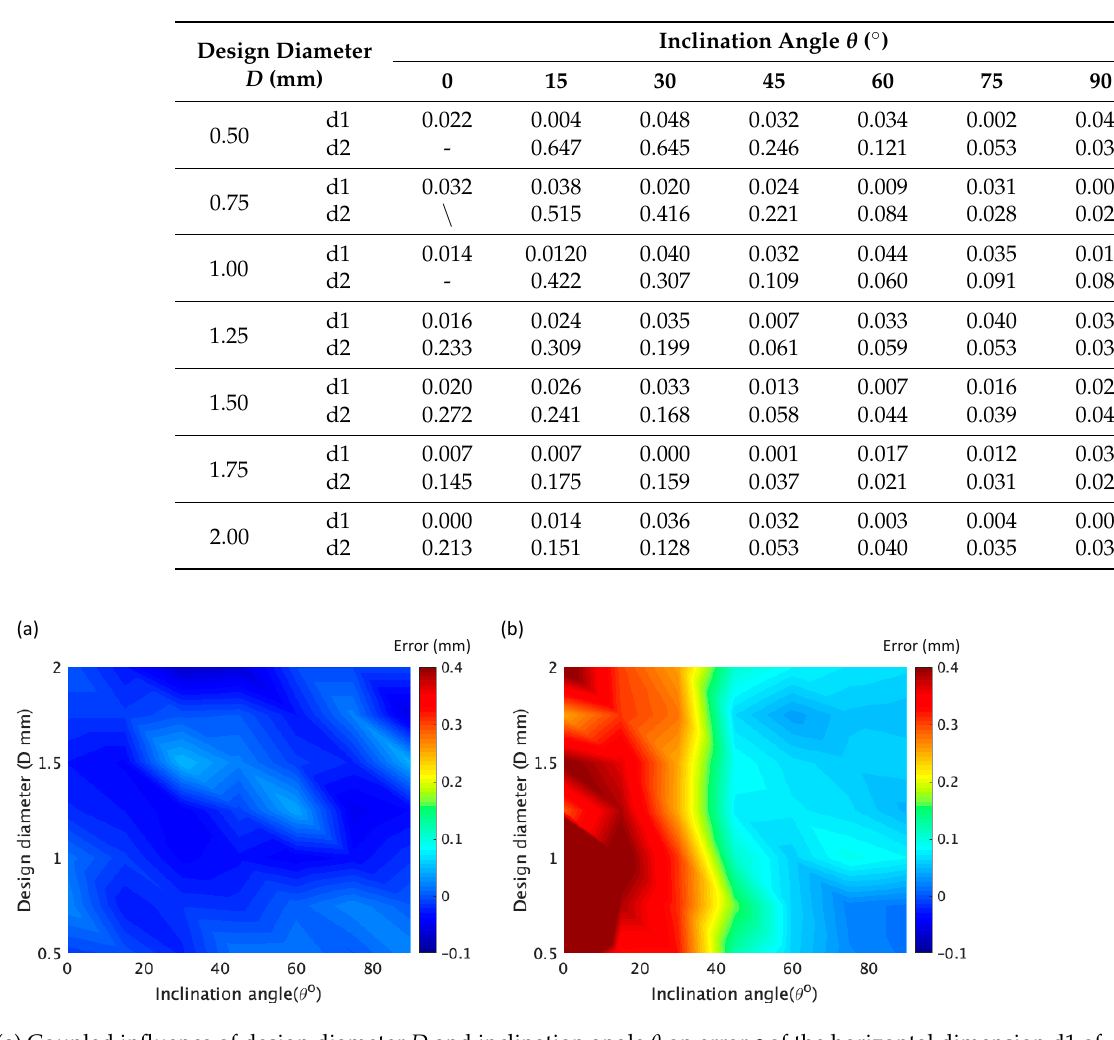
Table 4. The relative error of the rod unit.